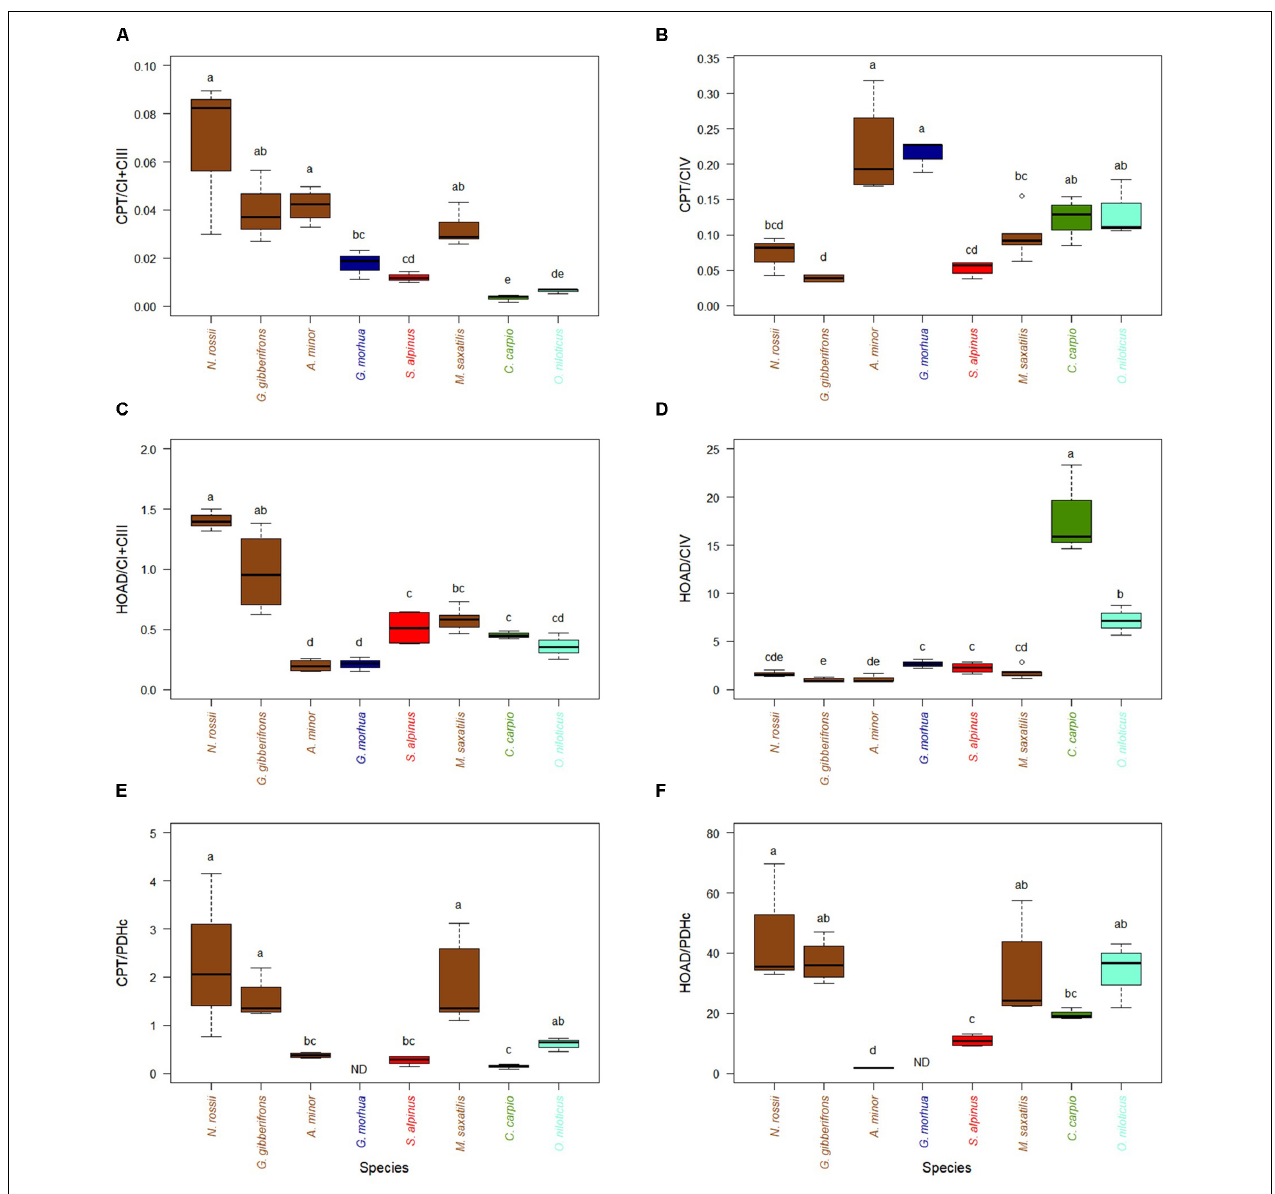
FIGURE 2 | Activity of mitochondrial substrate entrance enzymes of pyruvate pathway (normalized with ETS enzyme activities (CI + CIII and CIV) or PDHc, in hearts of cold-adapted fish (left), cold-temperate adapted fish, and fish species adapted to warmer habitats (right). Enzyme activities were measured at temperature near their thermal optimum. (A) Carnitine palmitoyltransferase (CPT) expressed relative to CI + CIII. (B) CPT expressed relative to CIV. (C) 3-Hydroxyacyl-CoA dehydrogenase (HOAD) expressed relative to CI + CIII. (D) 3-HOAD expressed relative to CIV. (E) CPT expressed relative to pyruvate dehydrogenase complex (PDHc). (F) 3-HOAD expressed relative to PDHc. Values are represented as mean ± SEM. Statistical differences are represented with letters ( p < 0.05). Notothenia rossii ( n = 3). Gobionotothen gibberifrons ( n = 4). Anarhichas minor ( n = 4). Gadus morhua ( n = 3). Salvelinus alpinus ( n = 4). Morone saxatilis ( n = 5). Cyprinus carpio ( n = 3). Oreochromis niloticus ( n = 3). Brown boxes represent Perciformes, dark blue Gadiforme, red Salmoniforme, green Cypriniformes, and light blue is Cichliformes.